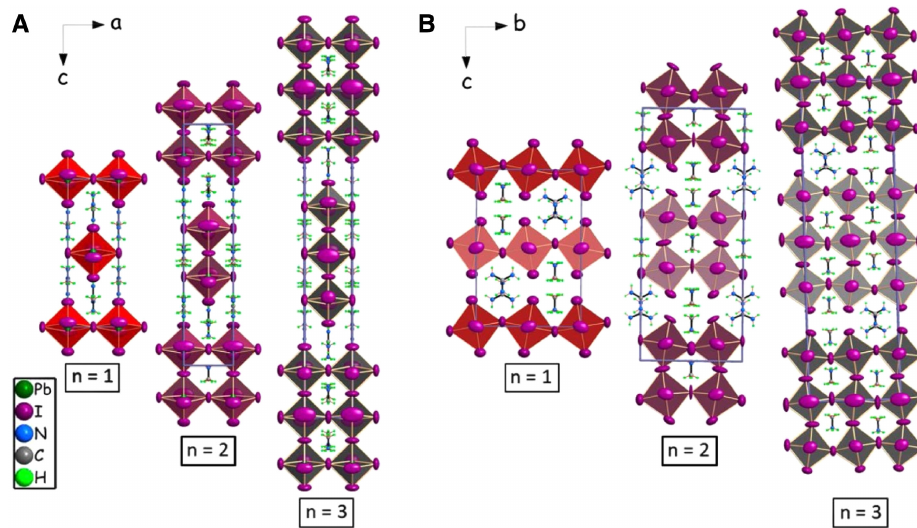
Pb I perovskite structures. n n 3 n + 1 Pb I ( n = 1–3) perovskites along (A) the crystallographic b -axis and (B) the crystallographic a -axis n n 3 n + 1